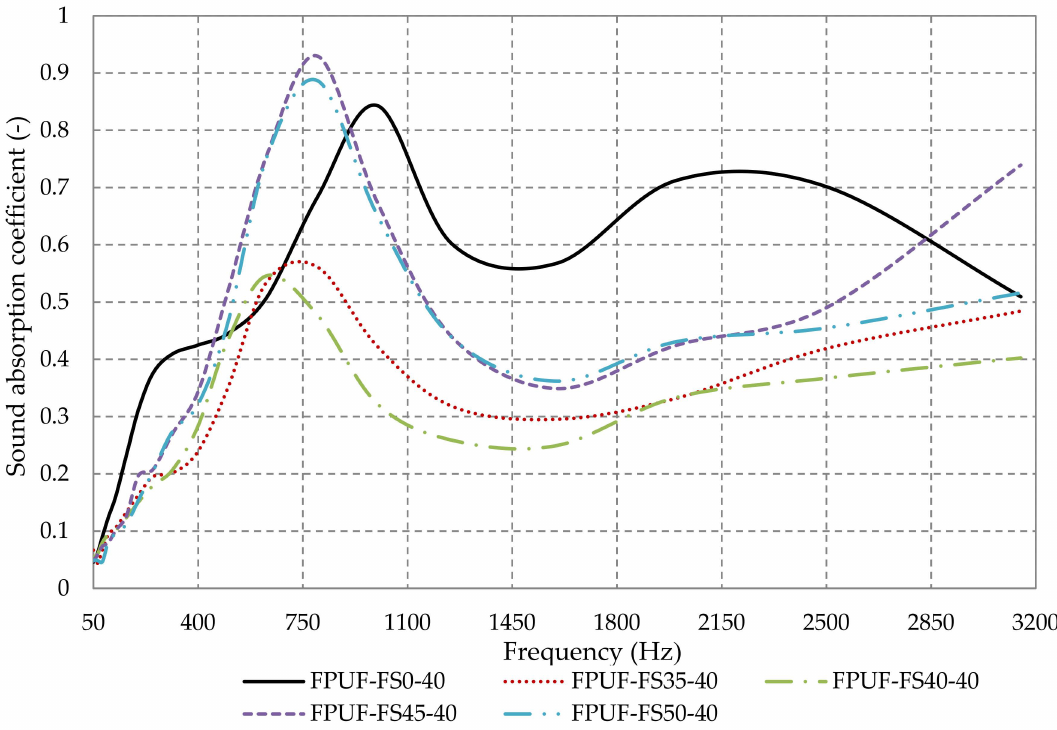
Figure 10. Sound absorption coefficient variation with the fir sawdust percentage in flexible polyurethane foam